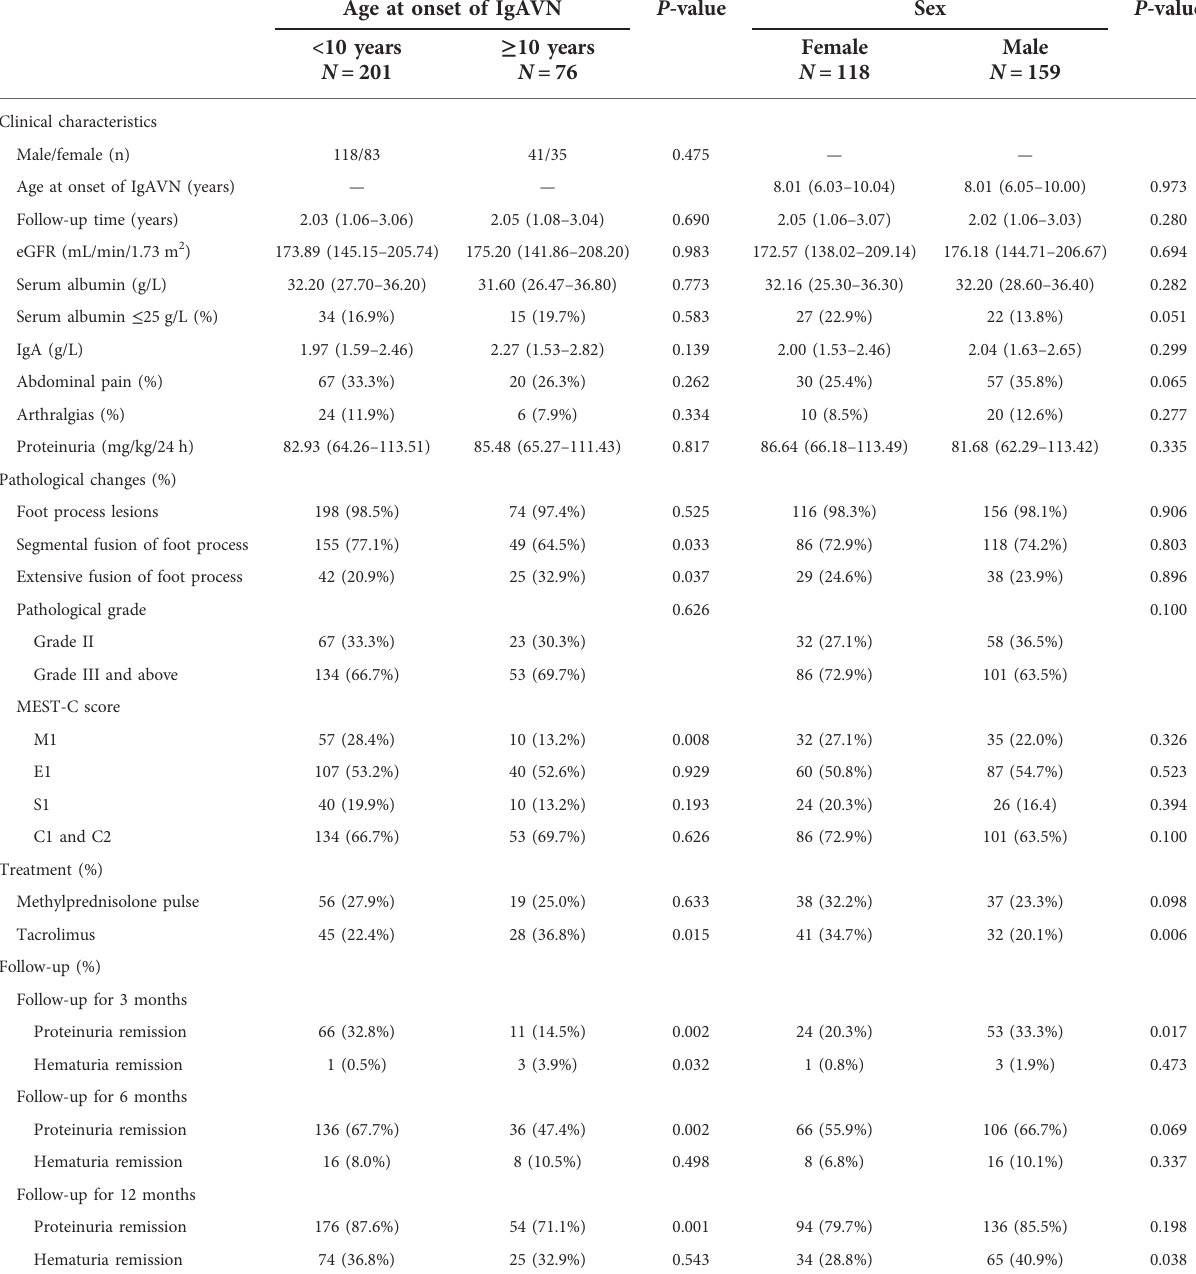
TABLE 2 Effects of onset age and sex on the severity of IgAV combined with nephrotic-range proteinuria. Age at onset of IgAVN P -value Sex P- value <10 years ≥ 10